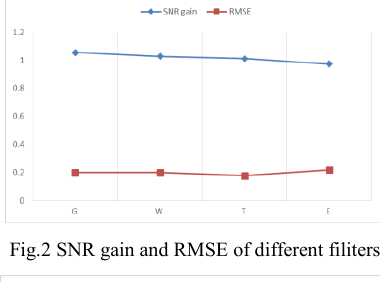
Fig.1 Denoising effect comparision of different filiters